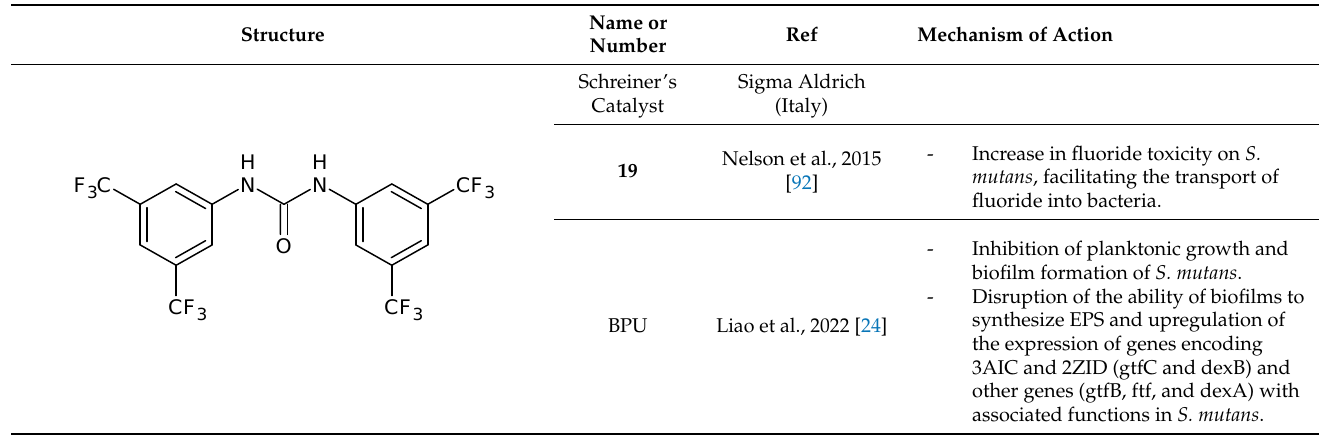
Table 1. Structures of diarylureas showing activity against S. mutans .